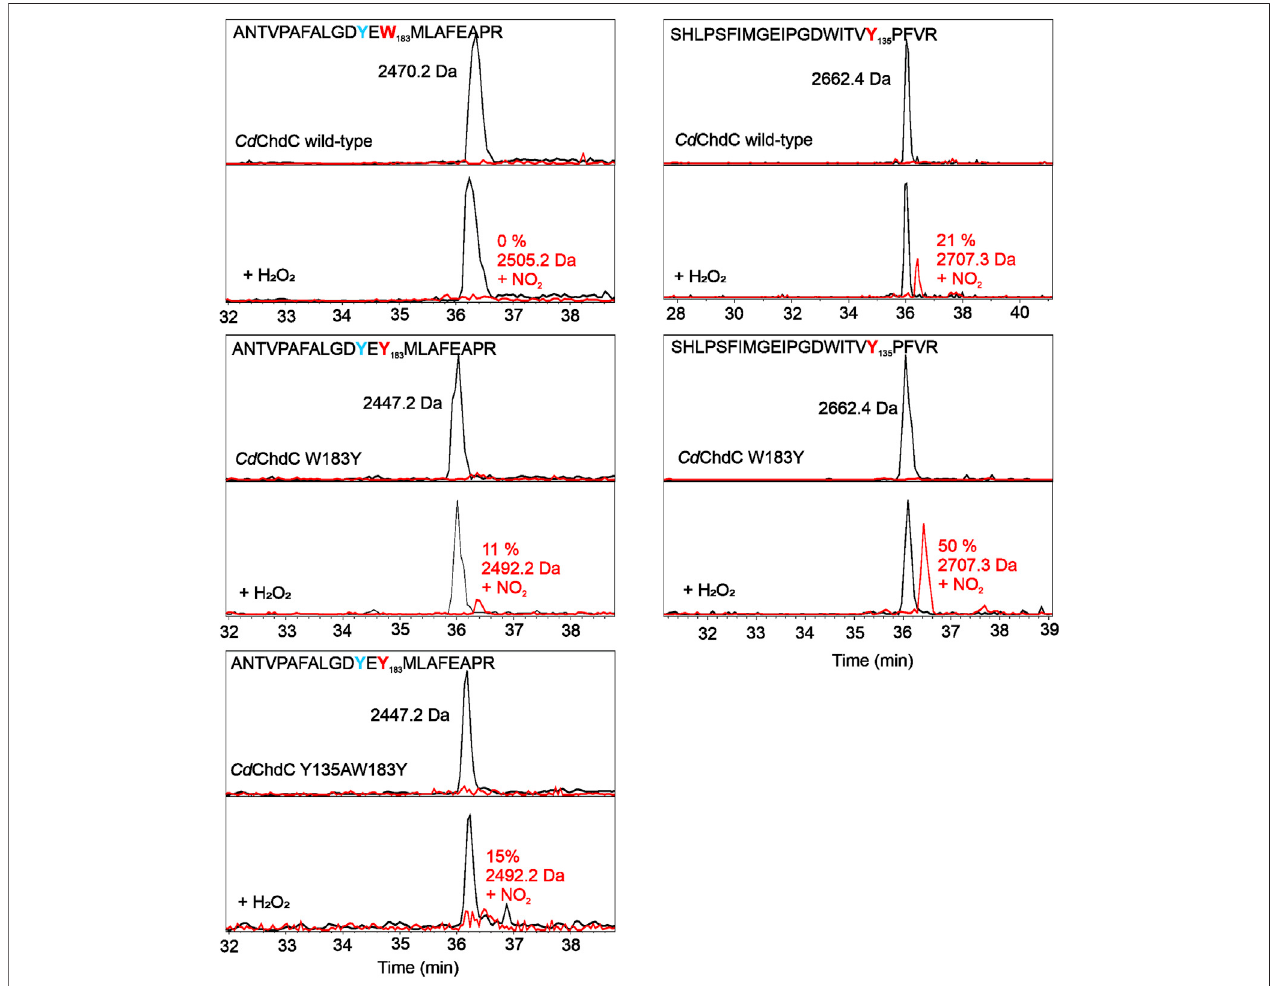
FIGURE 3 | Identi fi cation of tyrosyl radicals in Cd ChdC and variants W183A and Y135AW183Y by MNP spin trapping. Mass spectrometric analysis of Cd ChdC with MNP without (top) and after addition of hydrogen peroxide (bottom). Peptides with an additional 46 Da (NO 2 ) result from MNP modi fi cation of tyrosine radicals to